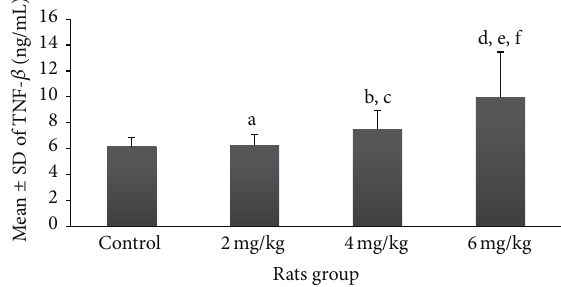
Figure 4: Prenatal exposure to nicotine in pregnant rat increased inflammatory marker TGF- 𝛽 in newborn rats. Mean ± SD of the TGF- 𝛽 marker is shown in different groups of newborn rats. 𝑁 = 8 (a: 𝑃 > 0.05 in 2 mg/kg group versus control group; b and c: 𝑃 < 0.05 and 𝑃 > 0.05 in 4 mg/kg group versus control group and 2 mg/kg group, resp.; d, e, and f: 𝑃 < 0.0001 , 𝑃 < 0.0001 , and 𝑃 < 0.001 in 6 mg/kg group compared to control, 2mg/kg, and 4 mg/kg groups, resp.).